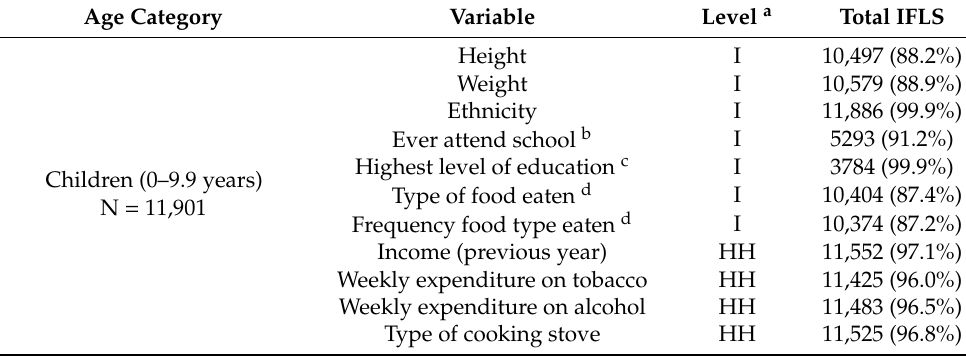
Table 7. Completeness of Confounder Data-number (%) of total individuals by age group for whom data are